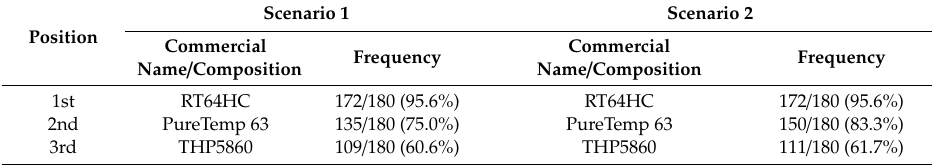
Caprylic acid + lauric acid (9:1 by mol)